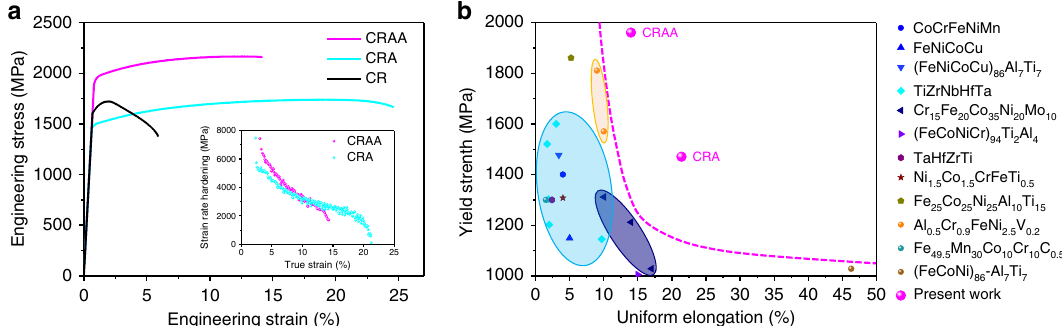
Fig. 1 Mechanical properties of our alloys with different treatment states at 25 °C. a Tensile curve of CR, CRA, and CRAA alloys, respectively. The insert in a presents the work-hardening rate ( d σ /d ε ) of CRA- and CRAA-treated alloys. b Maps of ε ue vs. σ y of high strength MEAs and HEAs with FCC or BCC matrix. The data of the mechanical properties of these reported materials are acquired from Supplementary Table